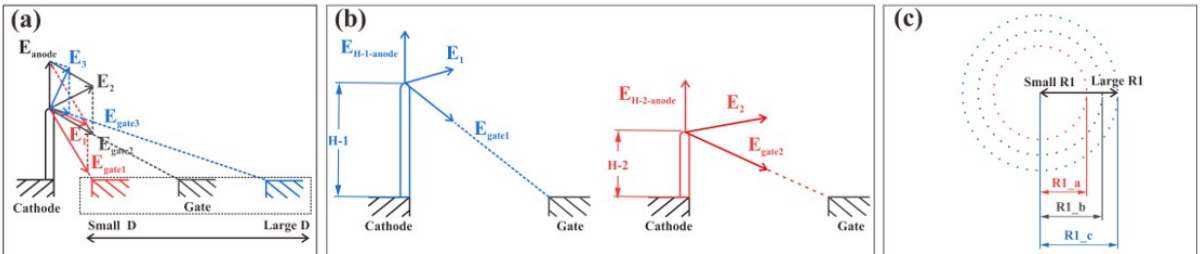
Figure 4. Schematic illustrations used to explain the simulation results. ( a ) The gate-induced electric field when the pixel size changes; ( b ) the electric fields under two different nanowire lengths; ( c ) the number of nanowires when R1 changes. The dot represents the outermost nanowires located at the periphery of the